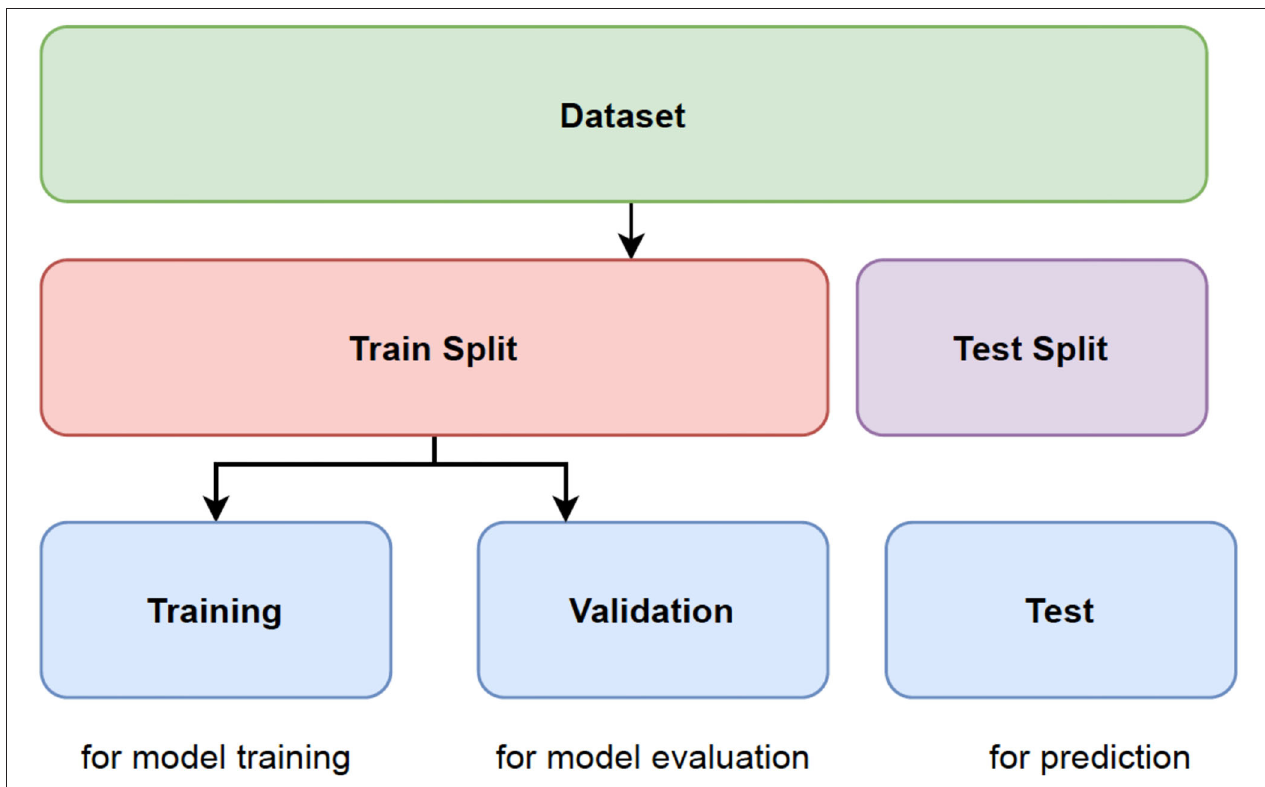
FIGURE 2 | Representation of data splitting.